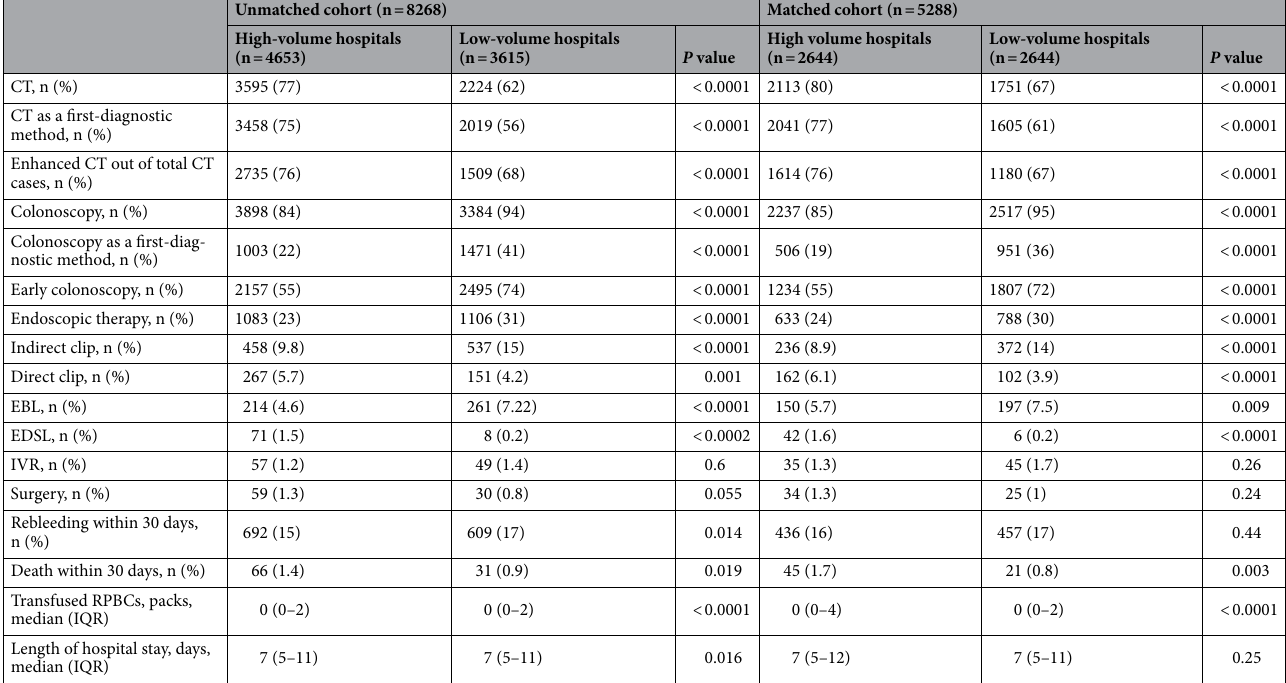
Table 2. Management and outcomes in patients with acute hematochezia in the unmatched and the matched cohorts: high-volume versus low-volume hospitals. A two-tailed P -value < 0.05 was considered to indicate statistical significance. CT computed tomography, EBL endoscopic band ligation, EDSL Endoscopic detachable snare ligation, IVR interventional radiology, PRBCs packed red blood cells, IQR interquartile